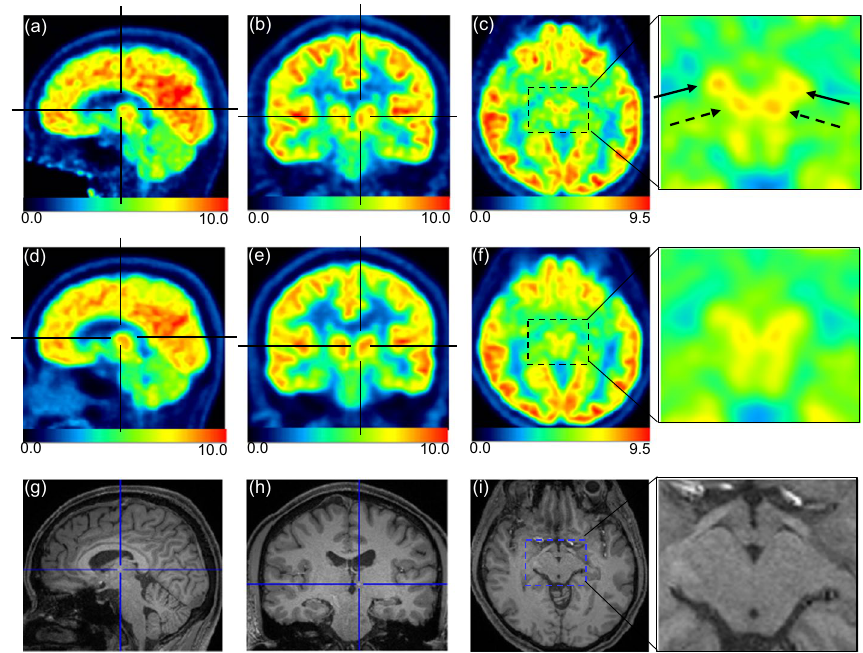
Fig. 3 FDG-PET images using Vrain are shown at the top ( a – c ) and those using the whole-body PET are shown in the middle ( d – f ). Images g – i show the T1WI MRIs. The centre of each crossbar is placed on the anterior nucleus ( a , d , g ) or the dorsomedial nucleus ( b , e , h ) in the thalamus. These are clearly visualised using Vrain ( a , b ) but not using the whole-body PET ( d , e ). The substantia nigra (arrows) and red nucleus (dashed arrows) are visualised using Vrain ( c ) with an expanded scale for the squared area on the right, but each region is not visualised separately using the whole-body PET ( f ). The SUV is indicated by the colour